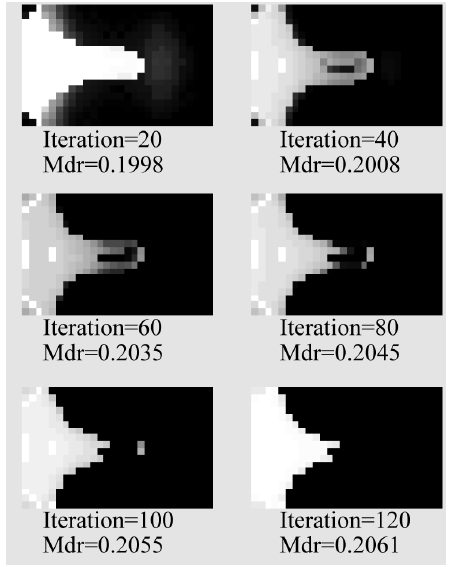
Fig. 10. Optimal distribution of damping material at different iteration numbers, vf =